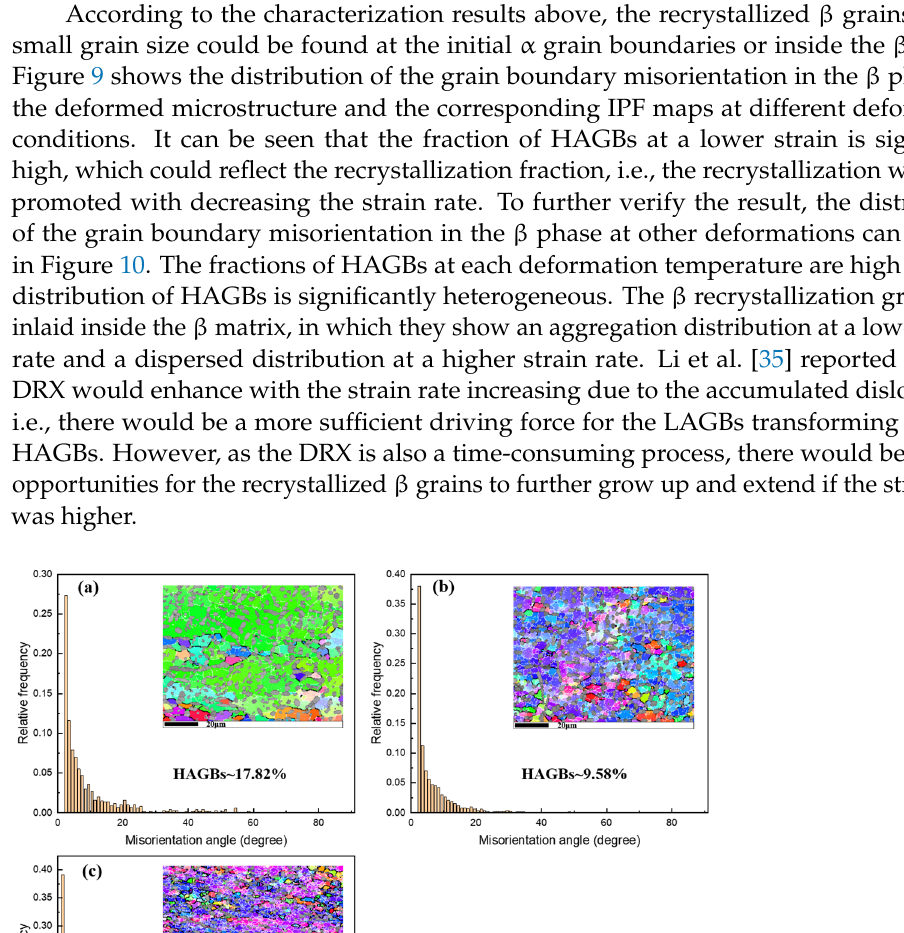
Figure 8. ( a ) The KAM values map of the β phase in local areas circled in Figure 4b; ( b ) the {110} β pole figure at arrow A; ( c ) the {0001} α pole figure at arrow B; ( d ) the {110} β pole figure at arrow C.